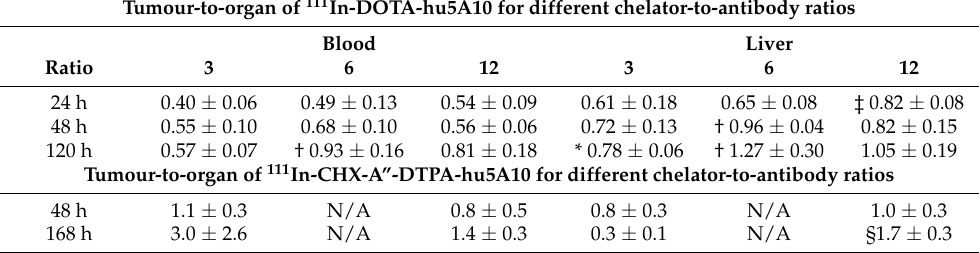
Table 3. The tumor-to-organ ratios for 111 In-CHX-A”-DTPA-hu5A10 and 111 In-DOTA-hu5A10 with 3:1, 6:1, and 12:1 chelator-to-antibody molar ratios in LNCaP xenografted BALBC-nu